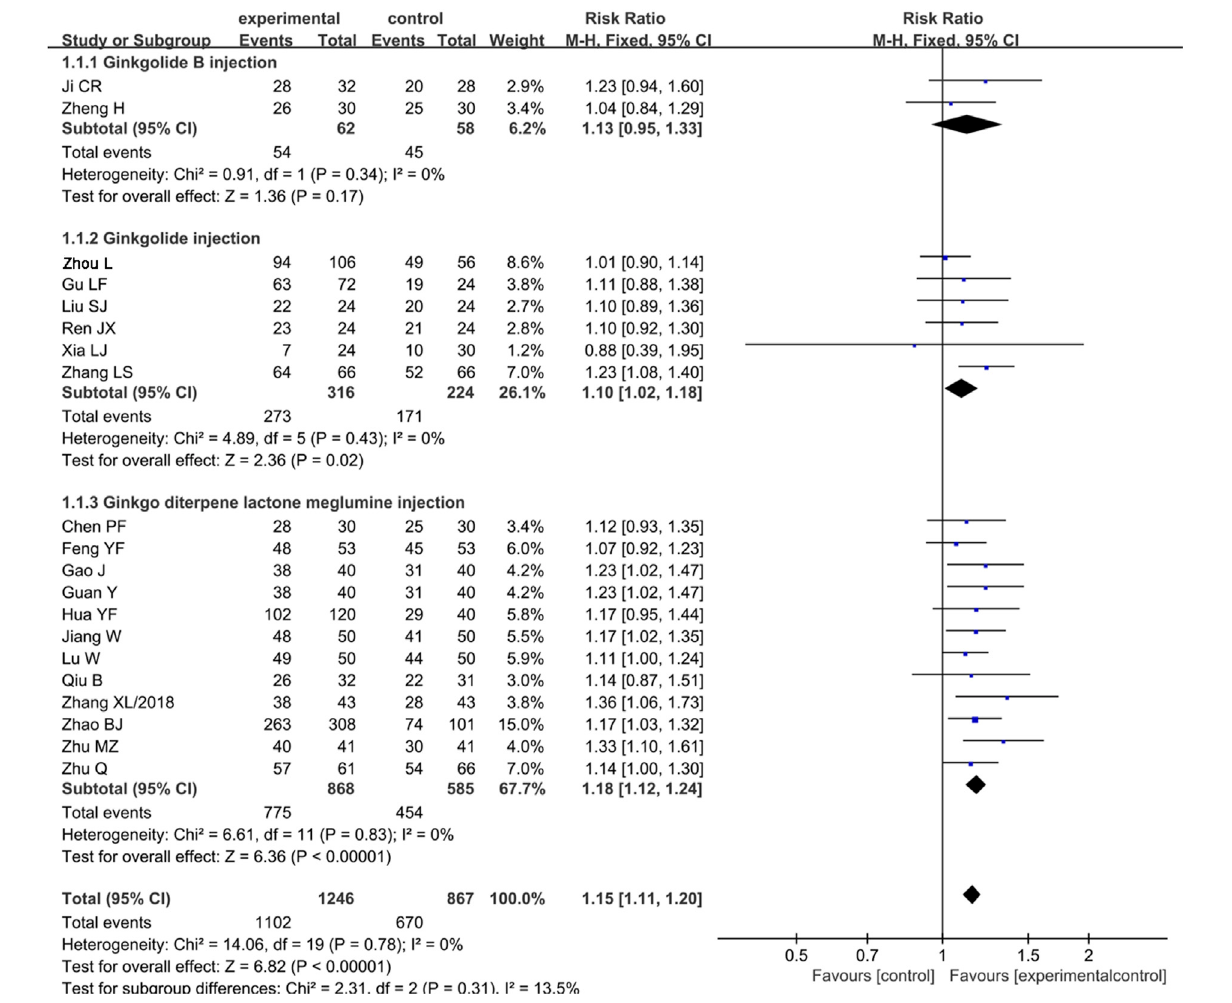
Frontiers in Pharmacology |